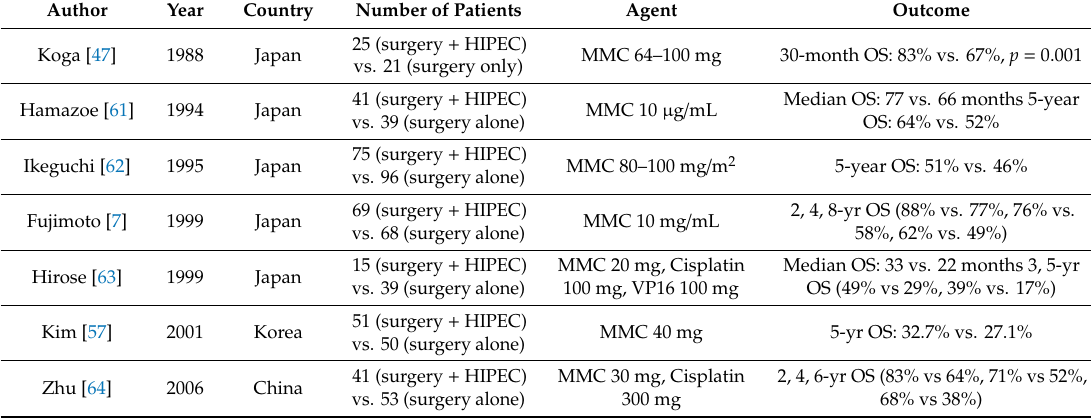
Prospective or randomized controlled studies evaluating the e ff ect of hyperthermic intraperitoneal chemotherapy (HIPEC) as prophylactic / adjuvant